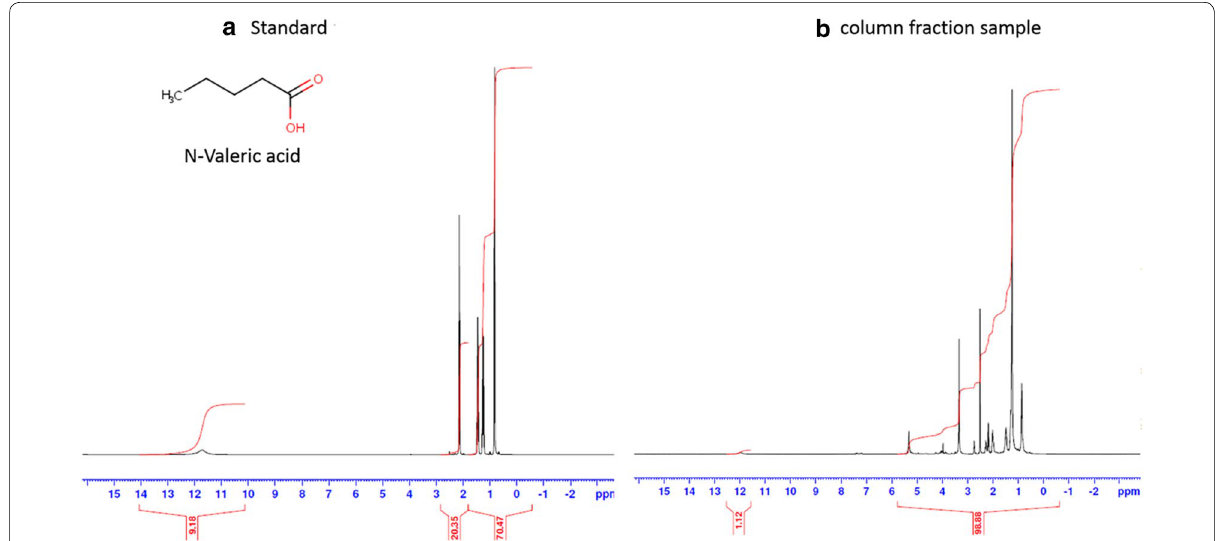
Fig. 3 NMR spectrum of column fraction of Talaromyces purpureogenus isolate- ABRF2 compared with standard. a n -Valeric acid or pentanoic acid as a standard. b Column fraction of ABRF-2 fungus strain